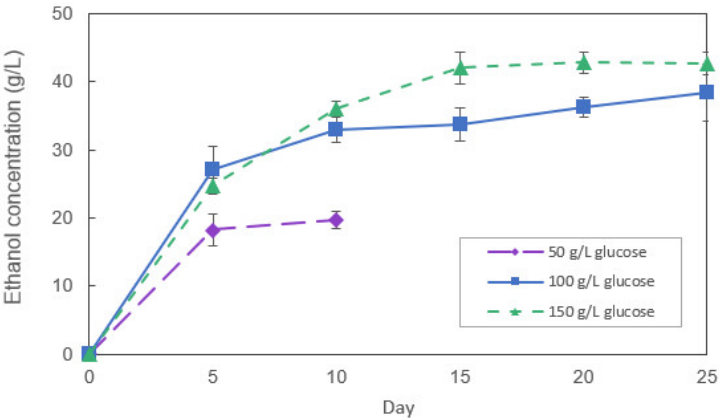
Figure 6. Ethanol production at high glucose concentrations by F. moniliforme BIOTECH